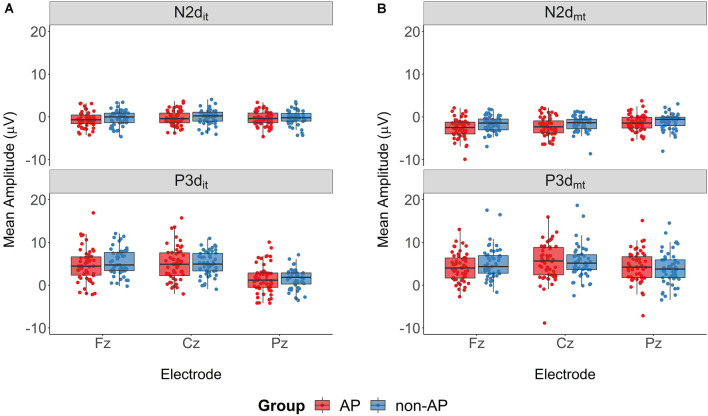
Mean amplitudes of the ERP components. (A) ERP components of the Nogoit-Go difference wave. AP musicians (depicted in red) and non-AP musicians (depicted in blue) had comparable N2dit and P3dit mean amplitudes. (B) ERP components of the Nogomt-Go difference wave. The 2 × 2 ANOVA revealed a Group × Electrode interaction for the P3dmt component. Post hoc analyses showed no evidence for a difference between AP and non-AP musicians at any electrode site.